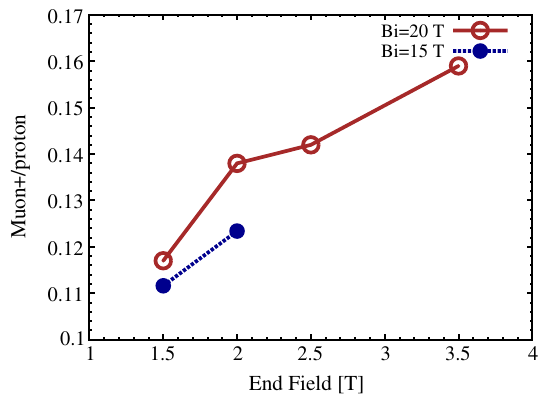
FIG. 12. Accepted positive muons per 8 GeV proton on target as a function of the final field. The target field is 20 and 15 T, and the taper length in both cases is 5 m.